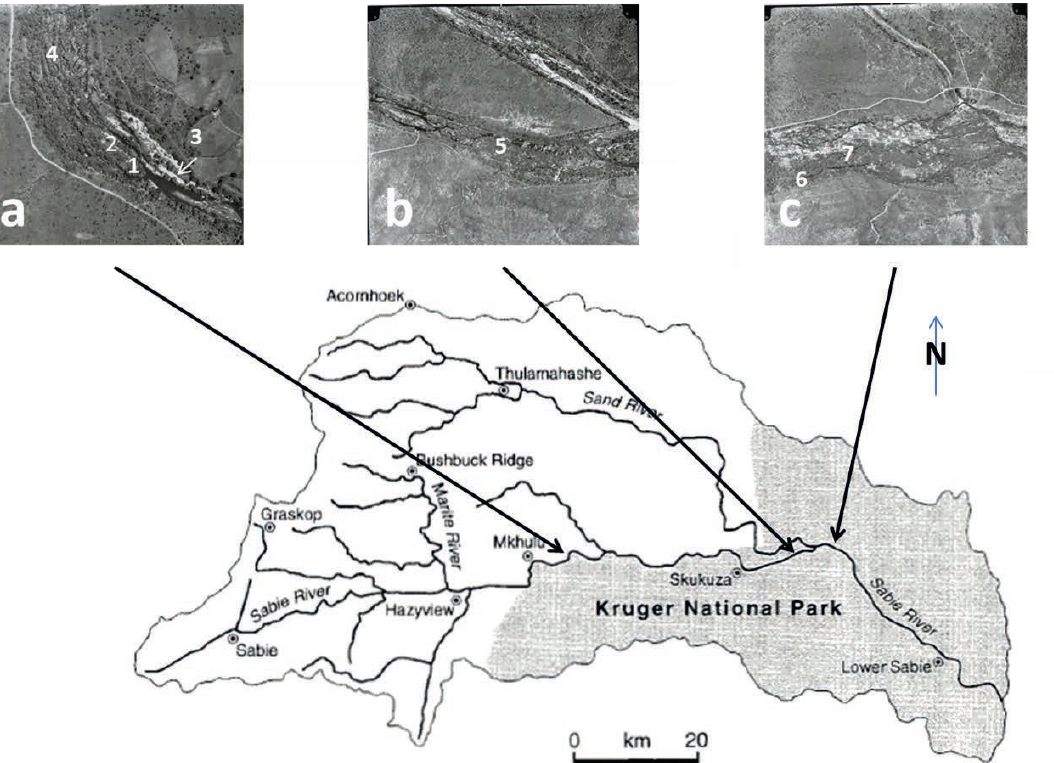
Fig. 3 Location map of optically stimulated luminescence samples collected from different depositional features on the Sabie River. Legend: 1- number of sample location in Table